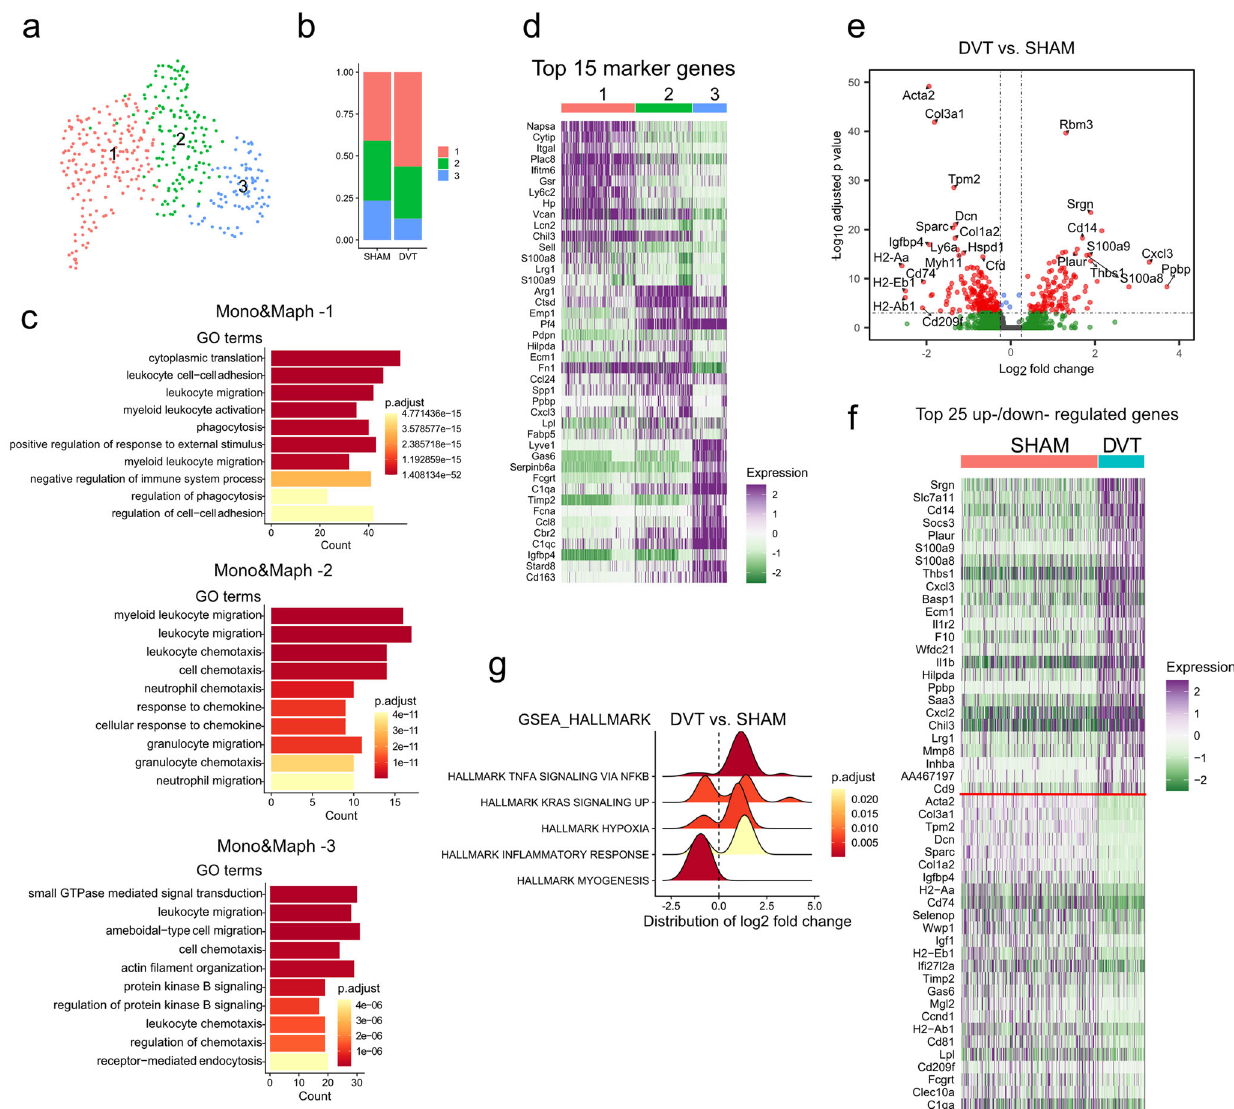
Fig. 5 Gene expression heterogeneity of monocytes and macrophages. a UMAP plot of sub-populations in monocytes and macrophages of sham and DVT data combined. b Relative distribution of sub-populations in sham and DVT groups. c GO analysis of each sub-population in comparison to the other two sub-populations. d Heatmap of the top 15 enriched genes in each sub-population in comparison to the other two sub-populations. e Volcano plot of DEGs in total monocytes and macrophages (DVT vs sham group). f Heatmap of the top 25 up- and downregulated genes in DVT compared to sham group. Up- and downregulated genes were separate by a red line. g GSEA of the altered gene sets in DVT versus sham